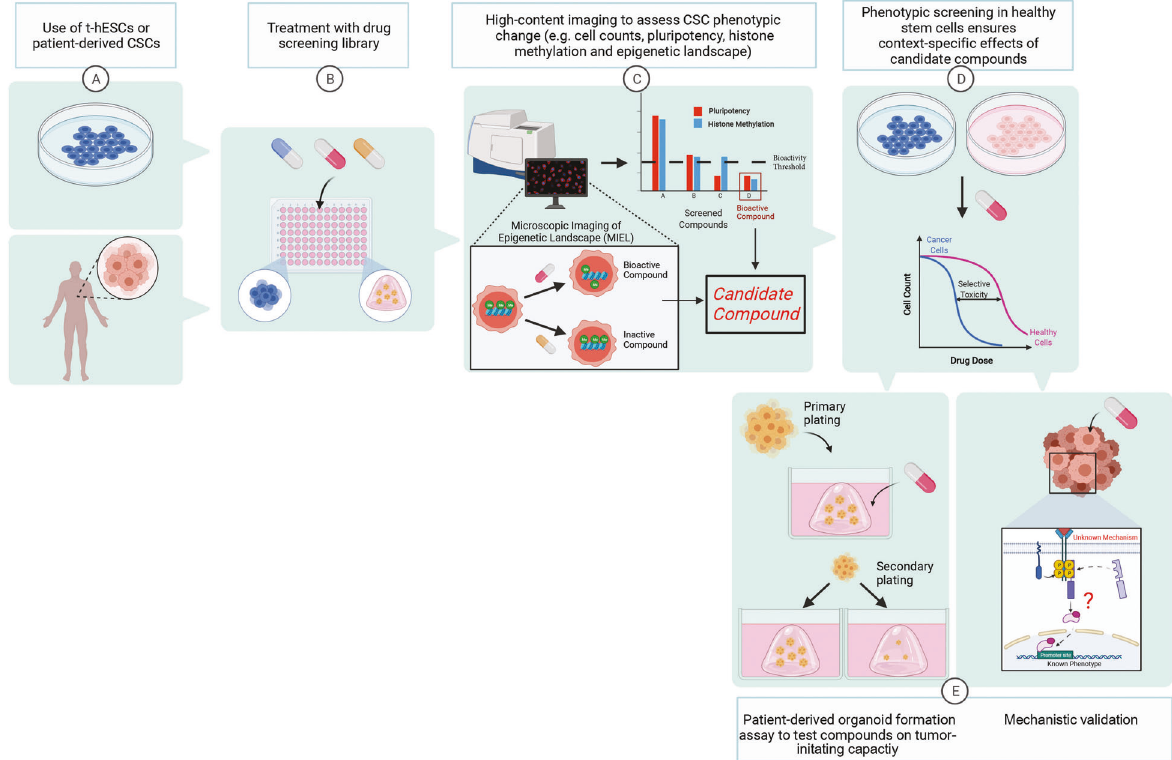
Fig. 3 Potential phenotypic screening approach to identify CSC-speci fi c inhibitors of G9a. High-content imaging and Microscopic Imaging of Epigenetic Landscape (MIEL) analysis on t-hESCs or patient-derived CSCs identify compounds that induce key phenotypes (e.g., loss of H3K9me2 deposition and/or OCT4 expression). The application of a cancer-selectivity screening step (or fi lter) involving CSCs vs. their healthy counterparts enables the exclusion of noncancer-speci fi c compounds. In parallel with mechanistic validation experiments,